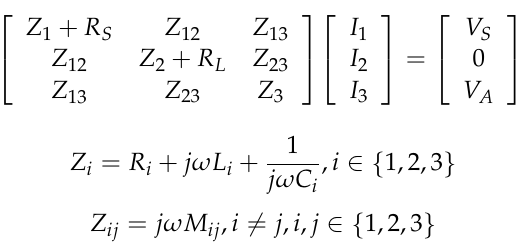
where B 1 , B 2 , B 3_ in , and B 3_ out are the magnetic flux density of the transmitting coil, re- ceiving coil, and the internal and external shielding coils at point M, respectively, and these are calculated corresponding to the coil design through (1). Moreover, the shielding effectiveness ( SE ) is defined as